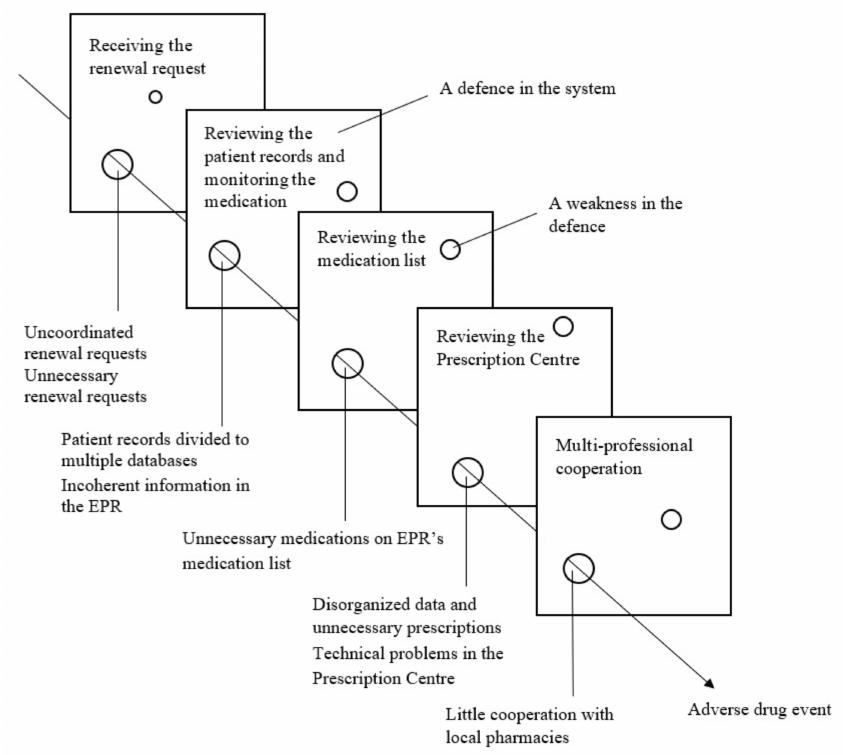
Figure 3. Patient safety risks identified in the renewal process and illustrated with Reason’s Swiss Cheese Model [30]. EPR = electronic patient